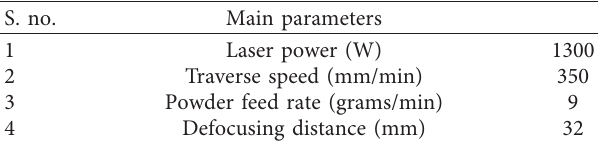
Table 9: Optimal parameters for laser hardfacing. S. no.